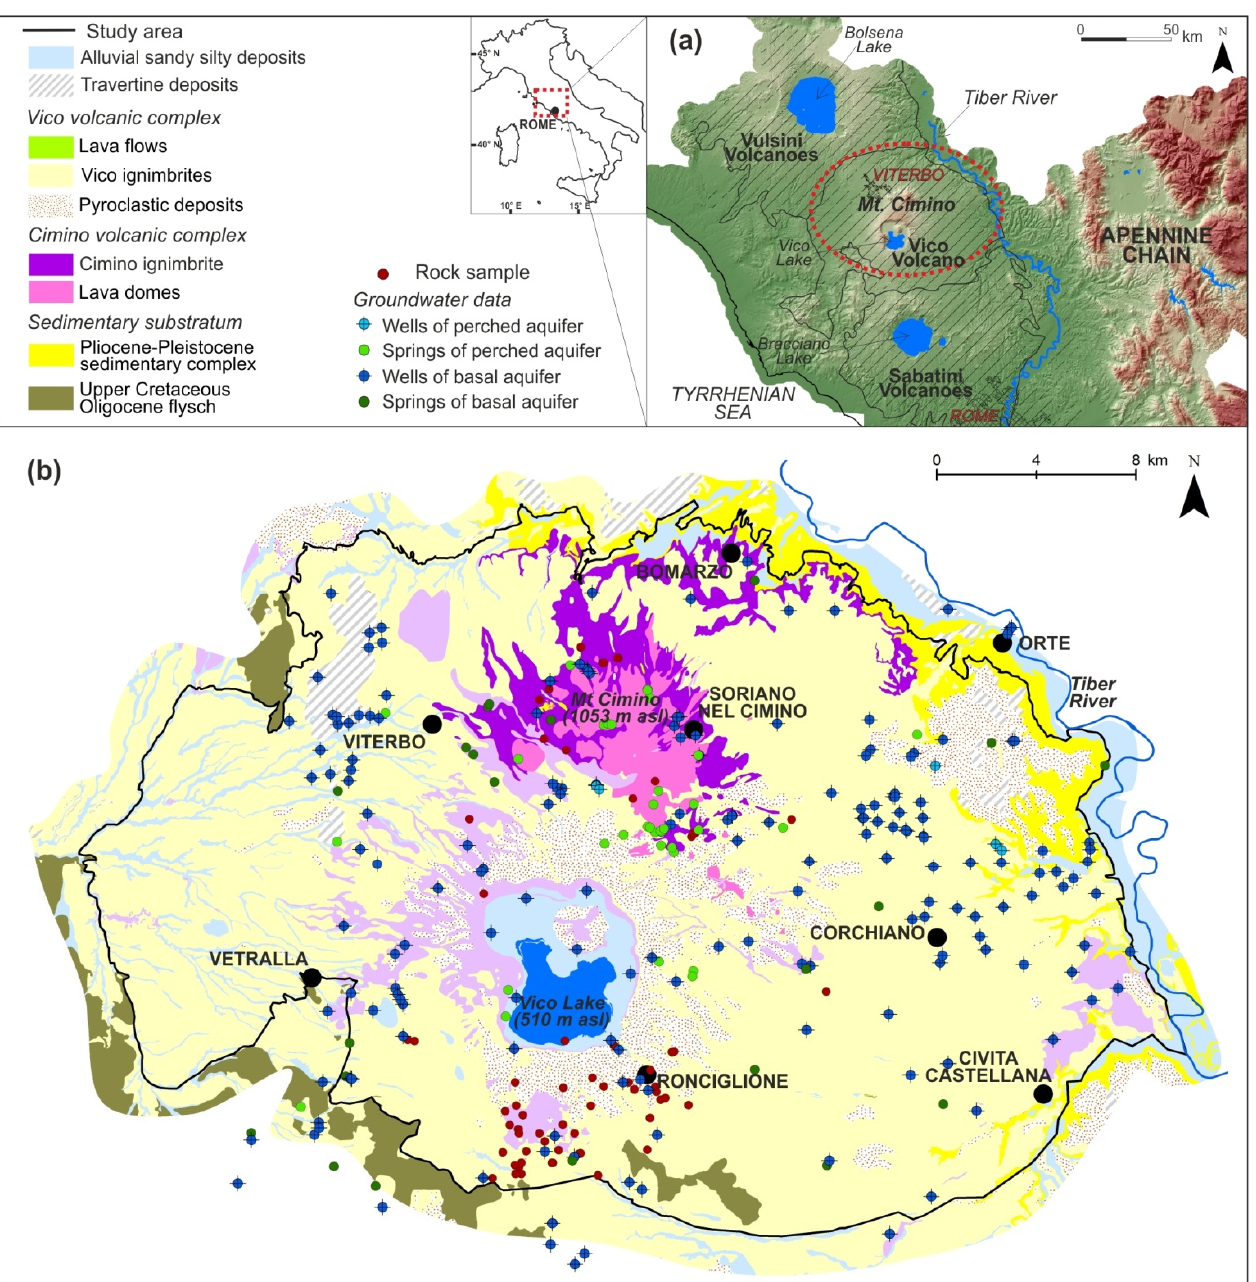
Figure 1. ( a ) Location of the study area; ( b ) Geological map of the Cimino-Vico volcanic area (modified from [23]) showing wells, springs, and rock samplings